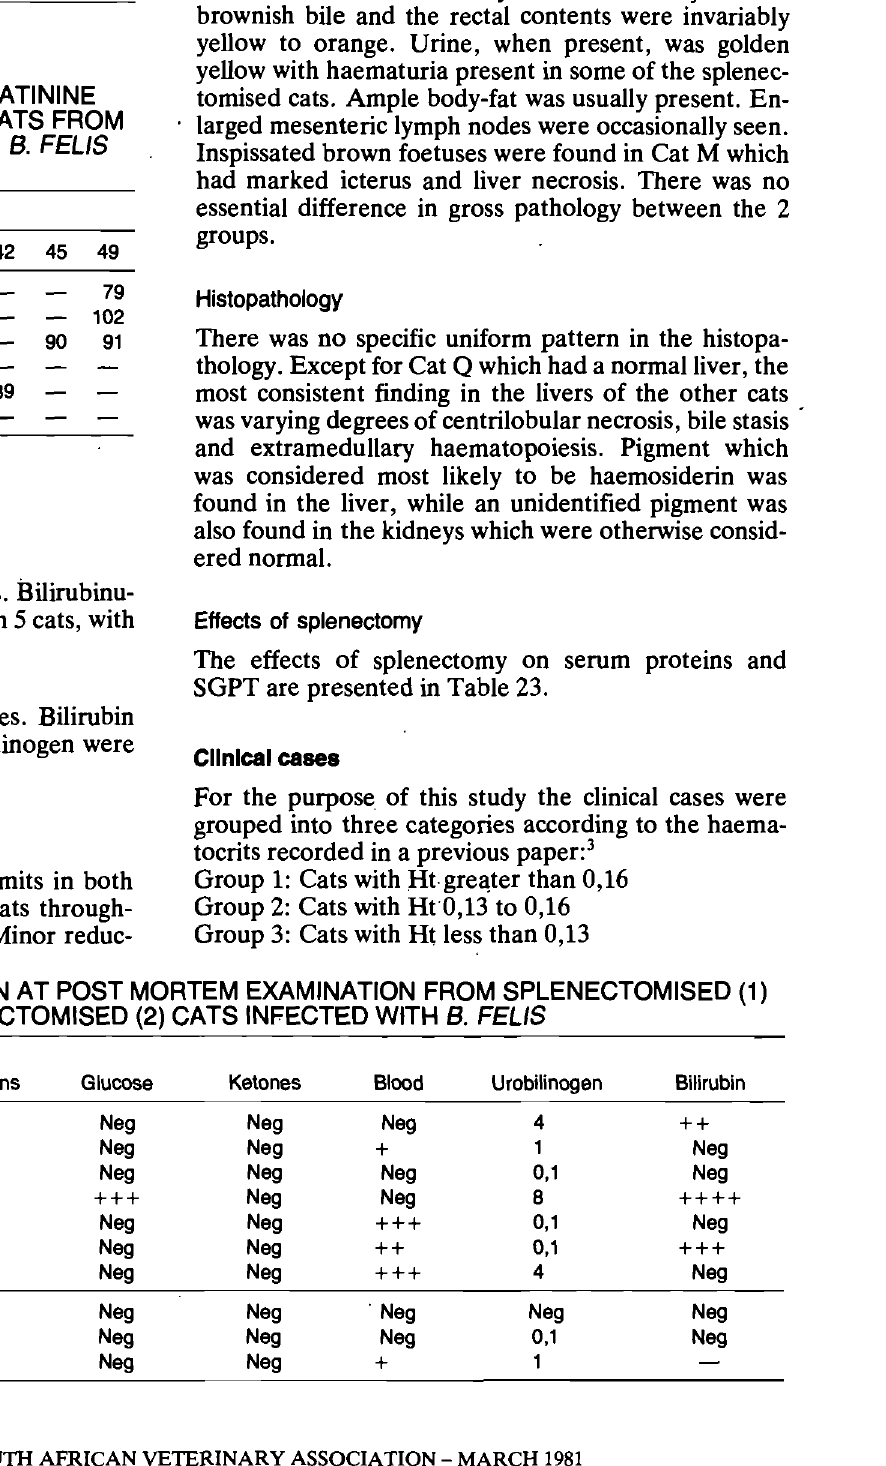
Table 21: CHANGES IN SERUM CREATININE (p.mol/t') IN NON-SPLENECTOMISED CATS FROM DAY OF INOCULATION (DAY 0) WITH B. FELIS